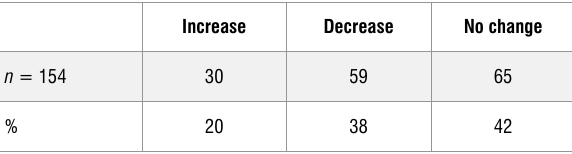
Table 1: Trends in Symons pan evaporation across South Africa, for a range of durations. All slopes ( β ) of evaporation with time p≤ 0.05 using a two-sided test.